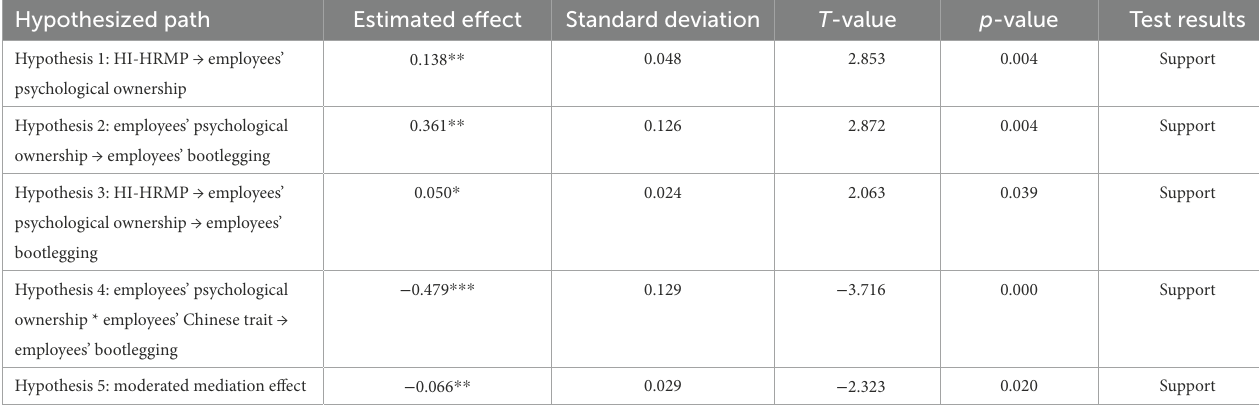
TABLE 4 Path coefficient of structural equation model ( N =